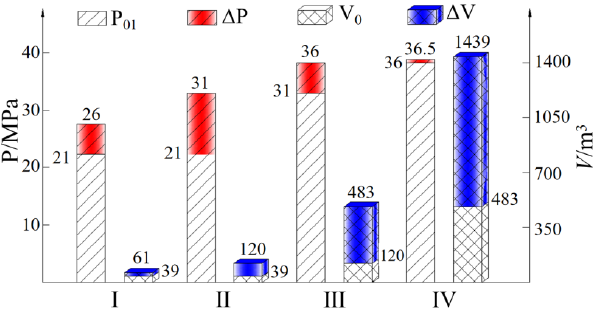
Figure 10. The statistical results of the numerical modelling data of events I to IV.